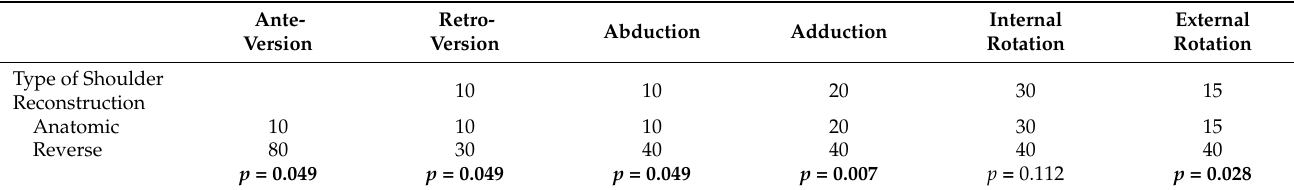
Table 4. Shoulder ROM for patients undergoing anatomic and reverse shoulder reconstruction with statistical significance in